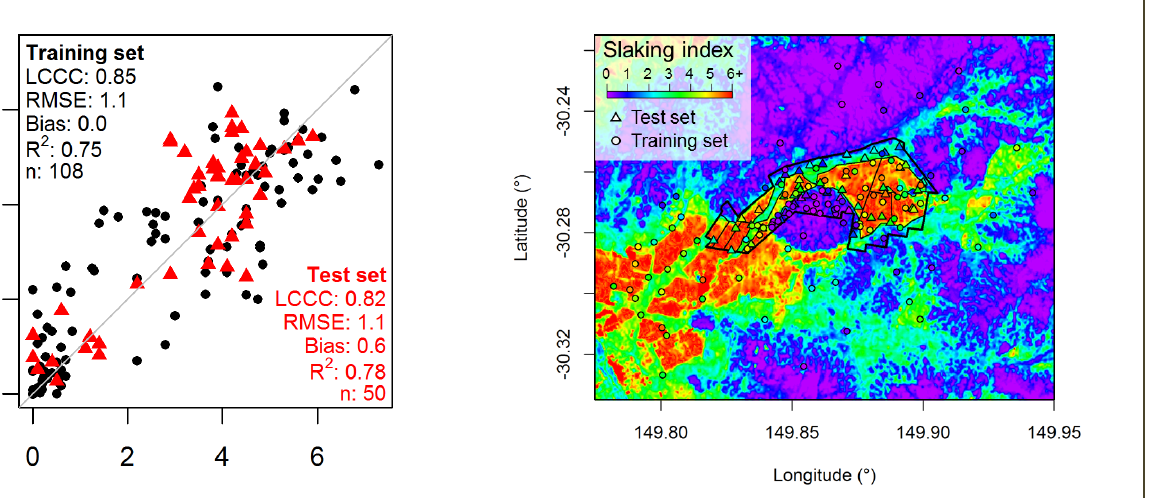
Figure 6. Prediction of slaking index (SI) across the study area us- ing regression kriging. The SI values at observation sites for the training set ( n = 108) and test set ( n = 50) are provided. The exter- nal perimeter boundary of L’lara is indicated by the thick black line, and boundaries of cropping paddocks are indicated by thin black